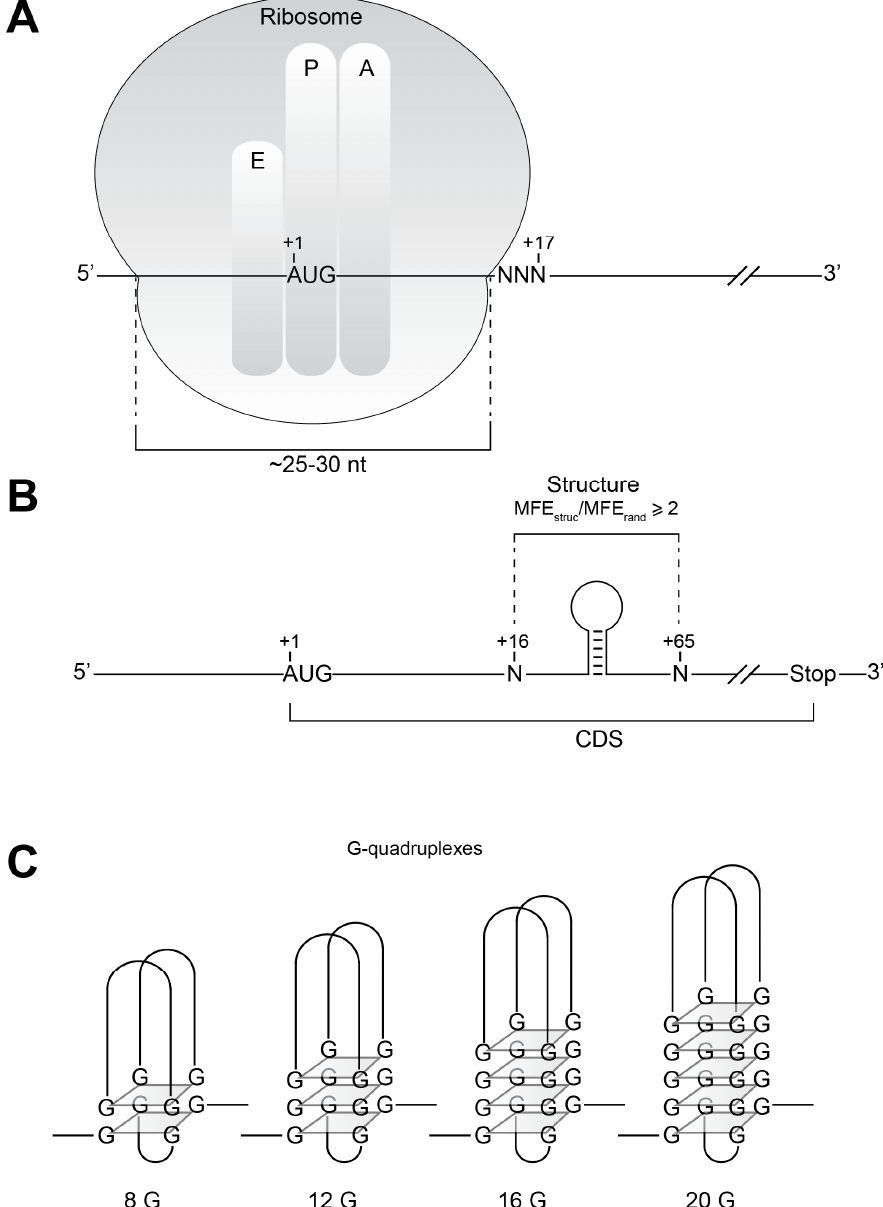
Figure 1. ( A ) During translation initiation, the assembled ribosome covers 15 to 17 nucleotides downstream from A (number + 1 by convention) of the AUG start codon. In the Structure Assisted RNA Translation (START) mechanism, the AUG start codon is positioned in the P-site of the ribosome by stable secondary structures located immediately downstream of the + 17 nucleotide. ( B ) In order to identify such putative new secondary structures, we screened the window + 16 to + 65 for putative secondary structures in the coding sequences (CDS). We focused on secondary structures with a minimal free energy (MFE struc ) that is at least two times higher than the mfe of the same sequence that was randomized 100 times (MFE rand ). ( C ) In addition, we also screened the same + 16 to + 65 window in CDS for G-quadruplex structures that contain 8, 12, 16 or 20